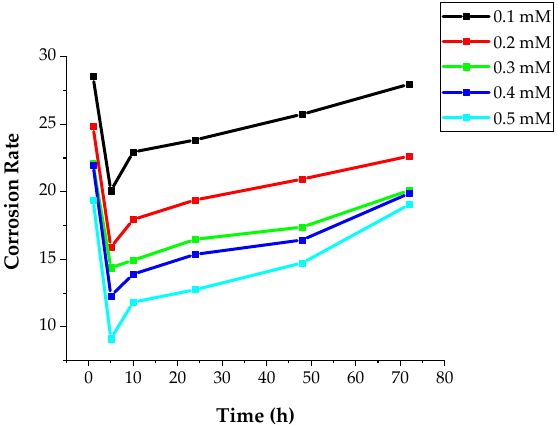
Figure 6. CR with various immersion times, h, in 1.0 N H 2 SO 4 solution at 30 °C with various concentrations of DMBHC.